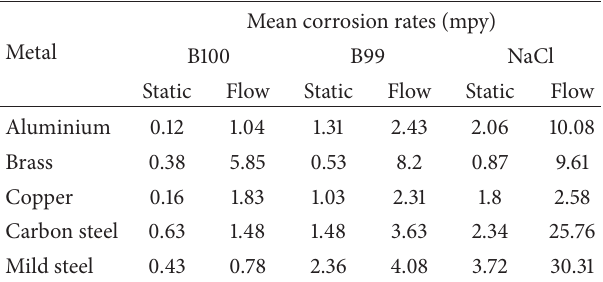
Table 3: Mean corrosion rates of various metals under static and flow conditions.